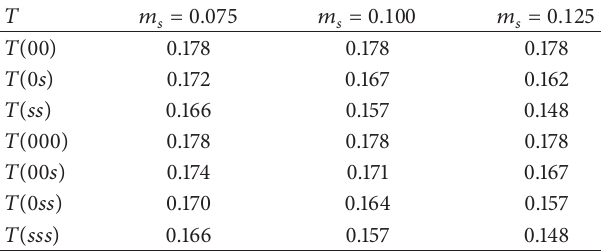
Figure 2: Nucleon formation by string breaking through 𝑞𝑞 pair production. Table 1: Hadronization temperatures for hadrons of different strangeness content, for 𝑚 𝑠 = 0.075, 0.100, 0.125 GeV and 𝜎 = 0.2 GeV 2